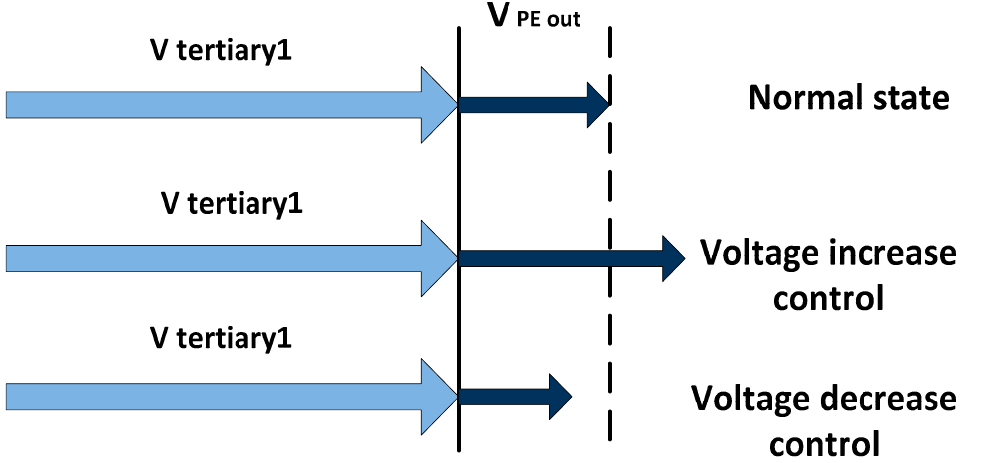
Figure 6. A vector diagram of the proposed voltage control.